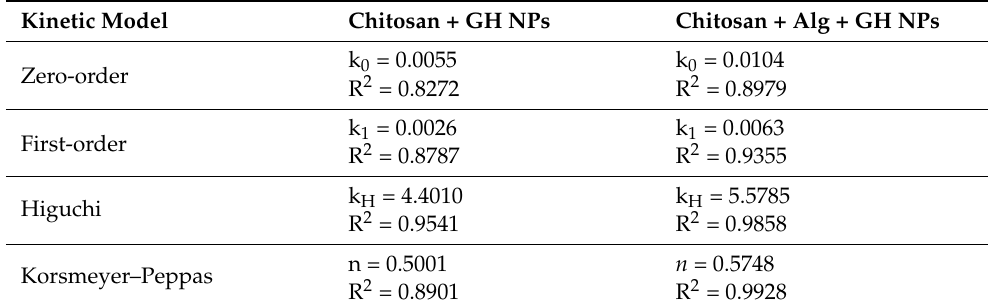
Table 3. Parameters derived from the different mathematical models describing the drug release